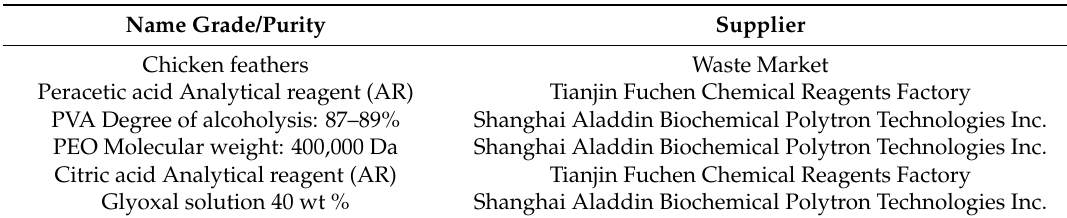
Table 2. Chemicals and materials.